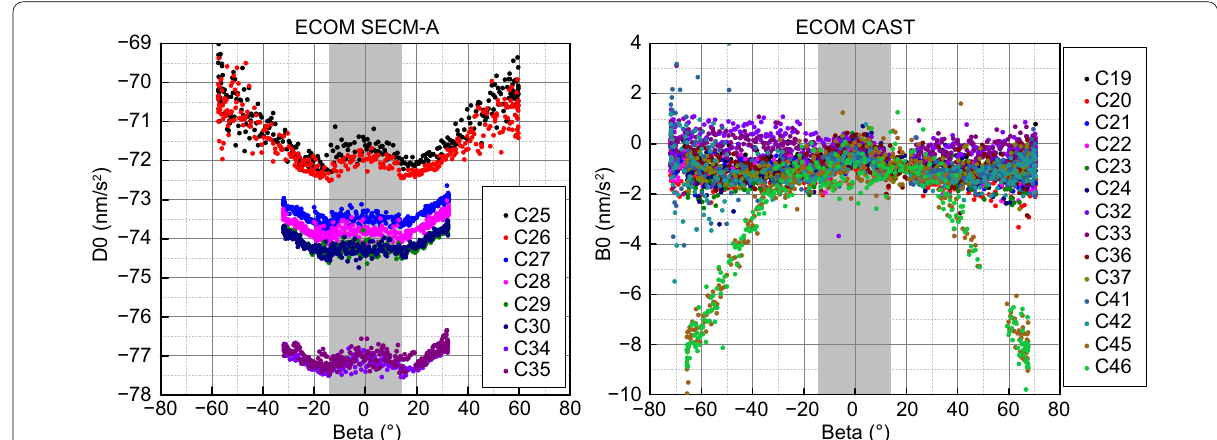
Fig. 10 Variations of D 0 and B 0 parameters of ECOM1 on β angle for SECM and CAST